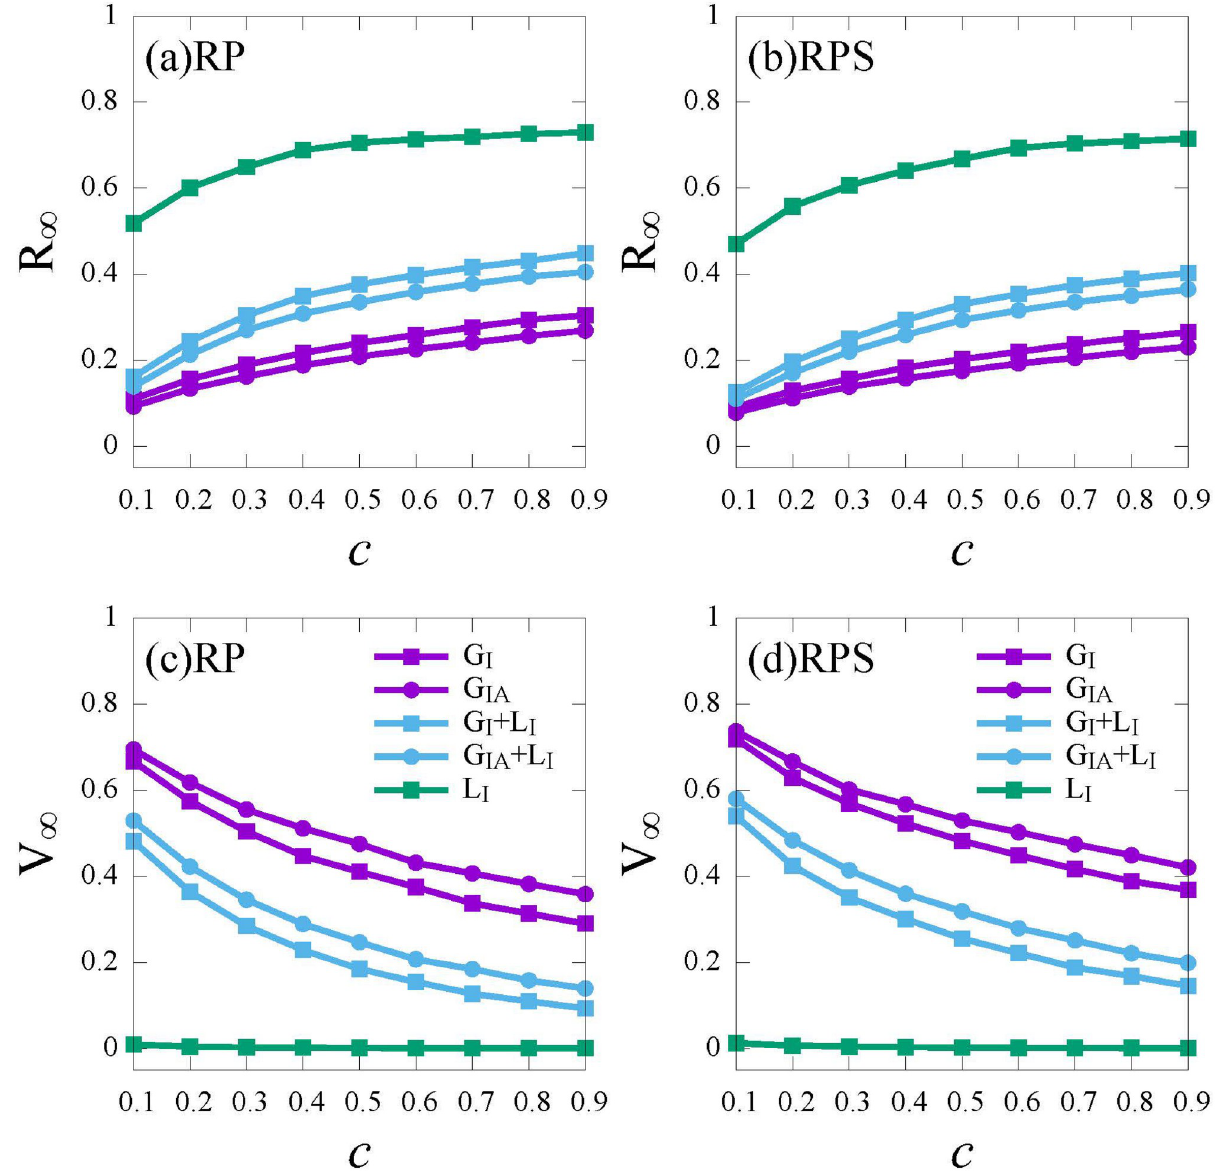
Fig 6. The final epidemic size ( R 1 ) and vaccine coverage ( V 1 ) versus the relative cost c under different information sources. Global I ( G I , purple, square), Global (c): RP strategy; (b) and (d): RPS strategy. Here, the infection rate λ = 0.5.